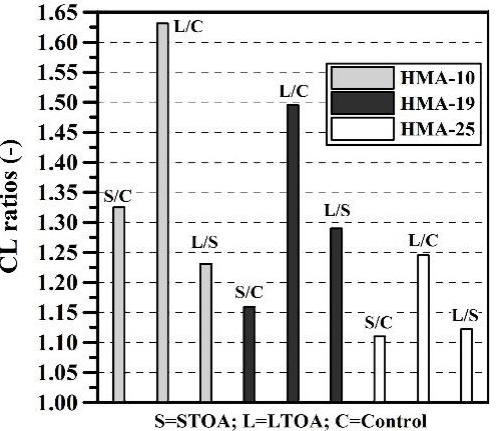
Figure 10. CL ratio of control mixes, STOA, and LTOA. Summary of results. Normally, mixes that present greater AV, greater particle sizes, coarse gradations, and lower VFA are more susceptible to aging [8,40,74,78–80]. Generally, this conclusion is based on the way it changes in stiffness (mainly in RM tests) of aged mixes with relation to the control mix. However, this study evaluated the change in other properties. Mixes that underwent the least and greatest changes under STOA and LTOA conditions with relation to the control mix are shown in Table 6. When two mixes appear in a box, it means that they underwent similar changes—in other words, changes that are not statistically significant based on ANOVA analysis. Table 6. Summary of aging susceptibility ratios of HMA mixes. Parameter